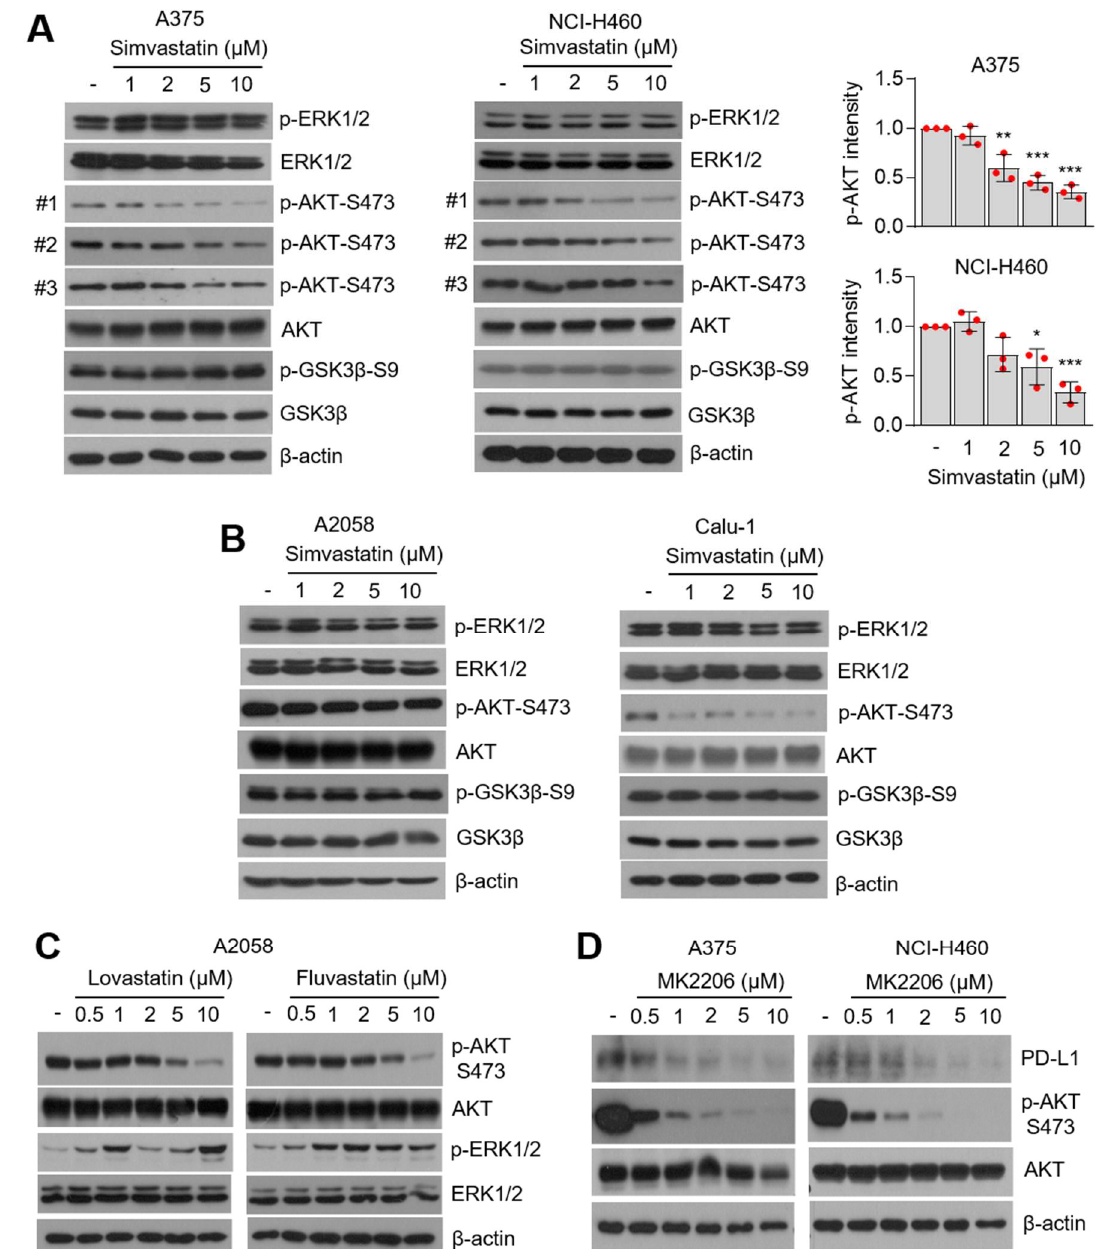
Figure 4. Inhibition of AKT-signaling involved PD-L1 suppression by statins. ( A ) Simvastatin decreased phosphorylation of AKT but not ERK1/2 and GSK3 β . A375 and NCI-H460 cells were incubated with different concentrations of simvastatin for 12 h, as indicated. Phosphorylated AKT protein levels were measured by using western blotting. Phosphorylated AKT intensity was quantified and represented by Image J and Graphpad Prism. Each phosphorylated AKT protein level in the statins-treated sample was compared to the vehicle sample. The values represent the mean ± SD from the three independent experiments (#1, #2, and #3) performed. Values represent mean ± SD. * p < 0.05, ** p < 0.01 and *** p < 0.001 by one-way ANOVA, followed by an appropriate post hoc test for the comparison between two experimental groups. ( B ) Simvastatin suppressed AKT phosphorylation in A2058 and Calu-1 cells. ( C ) Lovastatin and Fluvastatin attenuated AKT phosphorylation. ( D ) A selective AKT inhibitor, MK2206, decreased PD-L1 expression in lung cancer (NCI-H460) and melanoma (A375) cells. DMSO as a vehicle or different concentrations of MK2206 were treated in NCI-H460 and A375 cells, and were incubated for 6 h. Protein levels were measured by using western